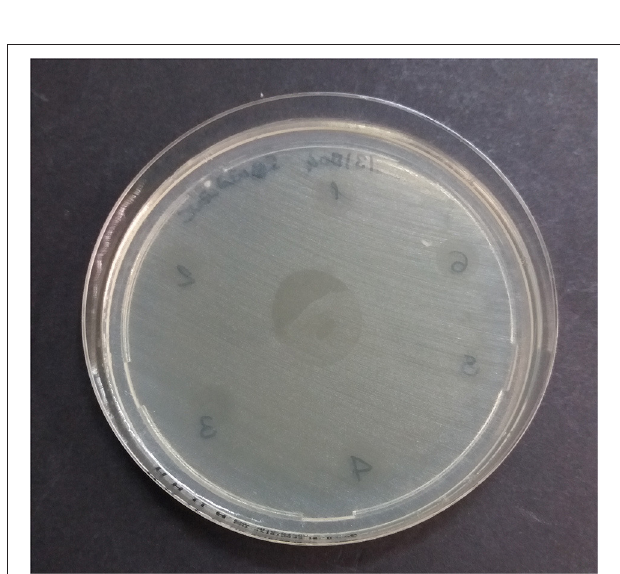
FIGURE 3 | Multidrug-resistant K. pneumoniae ssp. pneumoniae inhibition zones by pure formulations after 4h at 37 ◦ C aerobically. 1: fibrin glue; 2: calcium gluconate; 3: P-PRP; 4: P-PRP plus thrombin; 5: P-PRP plus calcium gluconate; 6: P-PPP; in the center of the plate: P-PG.